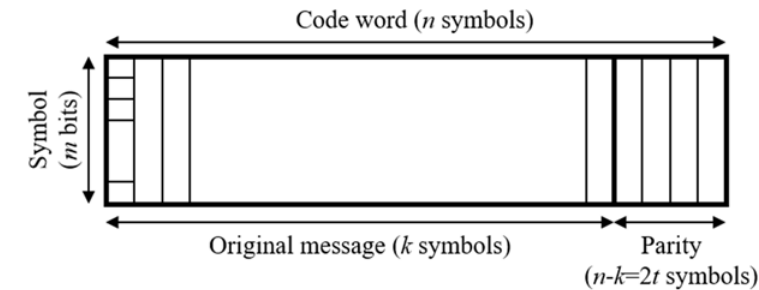
Figure 1. A Reed–Solomon encoded message.